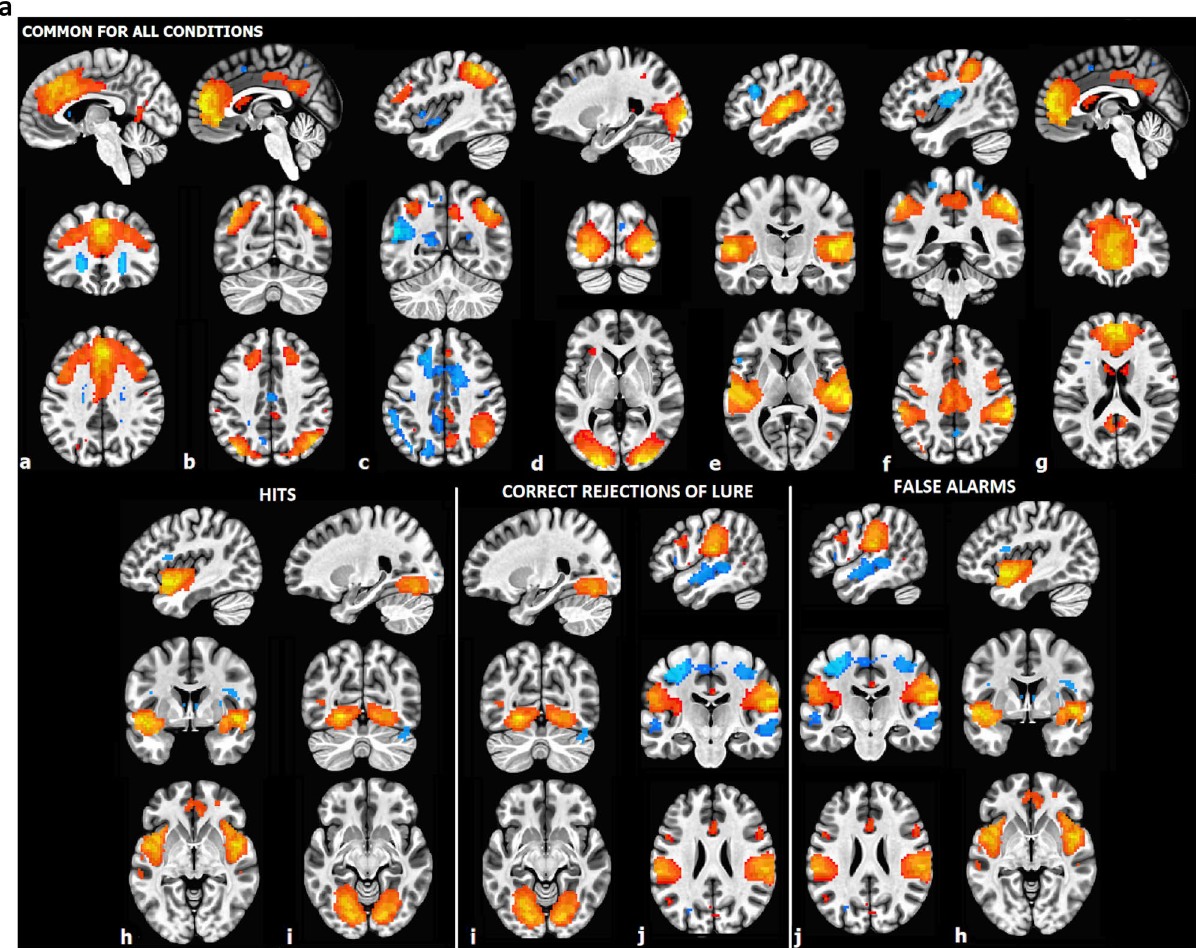
Figure 2. ( a ) The brain networks engaged in the encoding phase of the phonological task, common for all conditions and distinct for each of them (FDR corrected at p < 0.05 level). a—Executive network, b—dorsal attention network, c—right fronto-parietal network, d—lateral visual network, e—auditory network, f—sensory- motor network, g—anterior default mode network, h—insular network, i—medial visual, j—language network. ( b ) The brain networks engaged in the retrieval phase of the phonological task, common for all conditions and specific for hits and correct rejection of lure probes (FDR corrected at p < .05 level). a—Executive network, b—right fronto-parietal network, c—lateral visual network, d—medial visual network, e—left fronto-parietal network, f—language network, g—anterior default mode network, h—posterior default mode